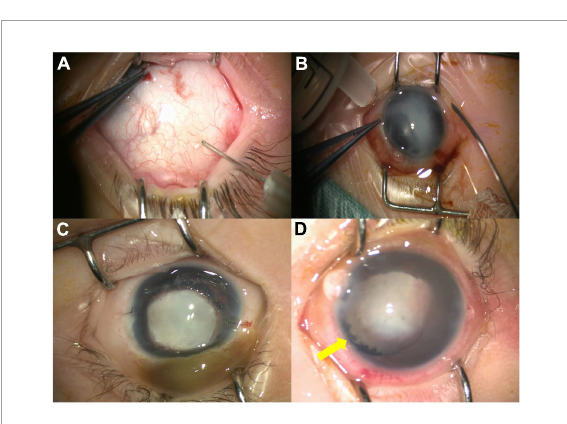
FIGURE5 The disadvantages of external drainage of subretinal fluid (SRF). Subretinal fluid external drainage (A) . The constant outflow of SRF may affect the surgical maneuvers and decrease the definition of surgical field (B) . The constant outflow of SRF can cause the subconjunctival effusion (C) . The iridodialysis (yellow arrow) can be caused by the sudden rapid outflow of SRF (D)